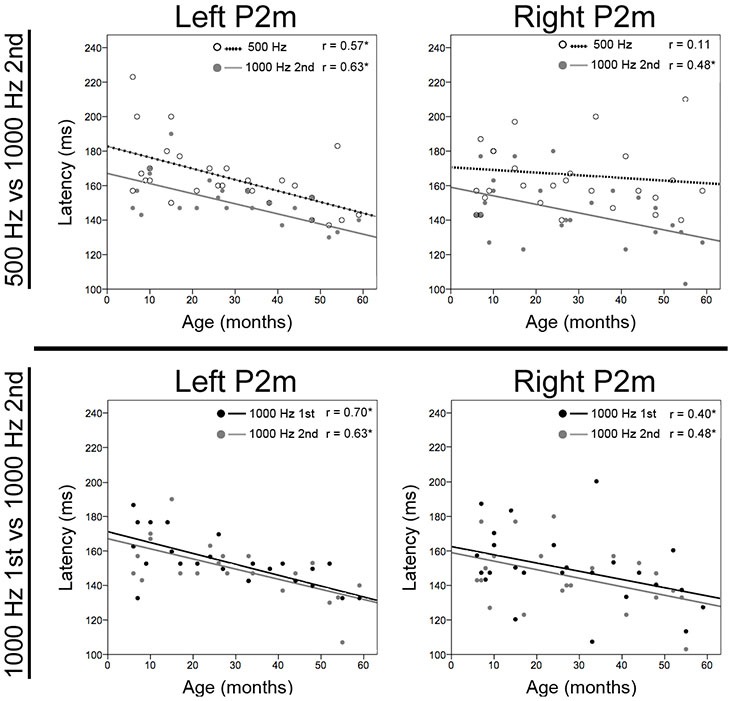
Scatterplots showing associations for each tone between age and left and right P2m latency. The top row shows associations for 500 Hz (open circle and dotted line) and 1000 Hz 2nd tones (gray circle and line), and the bottom row shows associations for 1000 Hz 1st (black circle and line) and 1000 Hz 2nd tones. The x axis shows age and the y axis latency. Significant correlations are marked with an “*”.